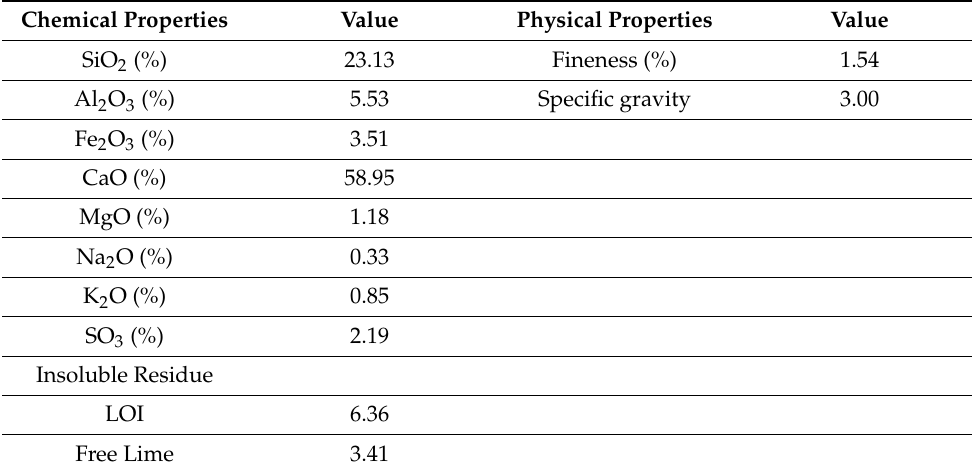
Table 3. Physical and chemical properties of